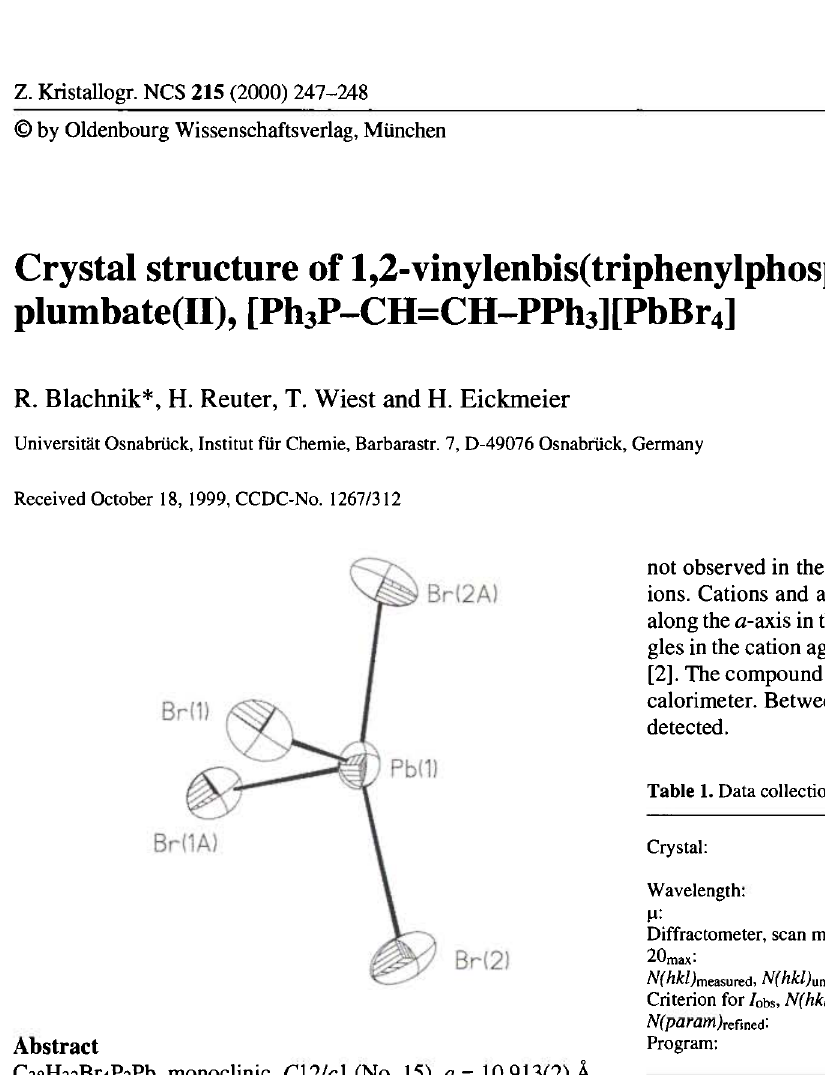
Table 2. Atomic coordinates and displacement parameters (in Ä 2